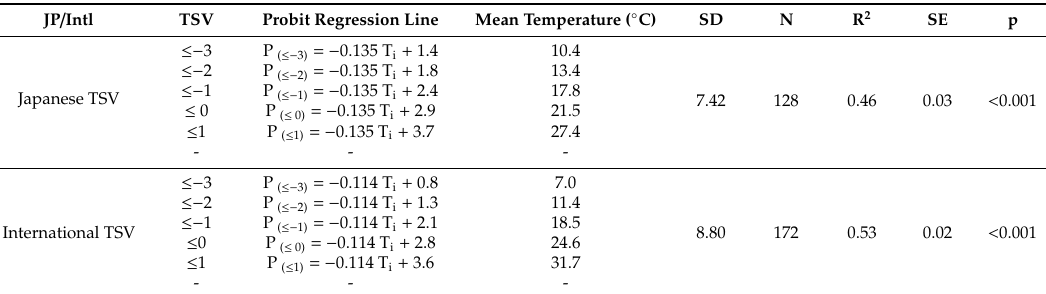
Table 8. Probit analysis of thermal sensation and indoor temperature.